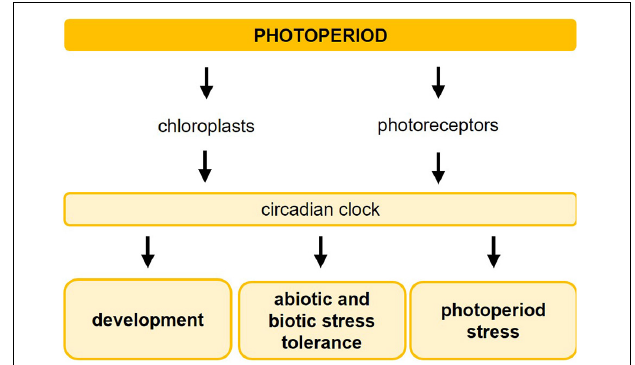
FIGURE 1 | Photoperiod sensing influences development of plants, induces abiotic and biotic stress tolerance, and causes photoperiod stress. The length of the photoperiod is detected by a sensing mechanism consisting of chloroplasts and photoreceptors, which transfer the light information to the circadian clock. The interplay between the photoperiod and the circadian clock regulates developmental processes, such as flowering, tuberization, bud setting, dormancy, and senescence, and improves the plants’ tolerance to abiotic and biotic stresses. A sudden prolongation of the photoperiod results in photoperiod